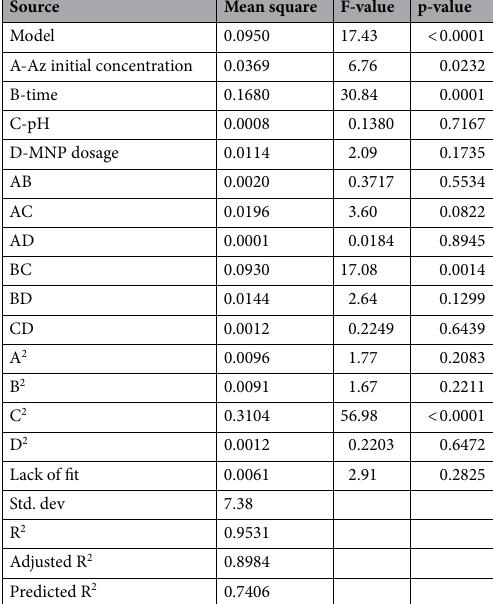
Table 4. Results of ANOVA by Design Expert software.